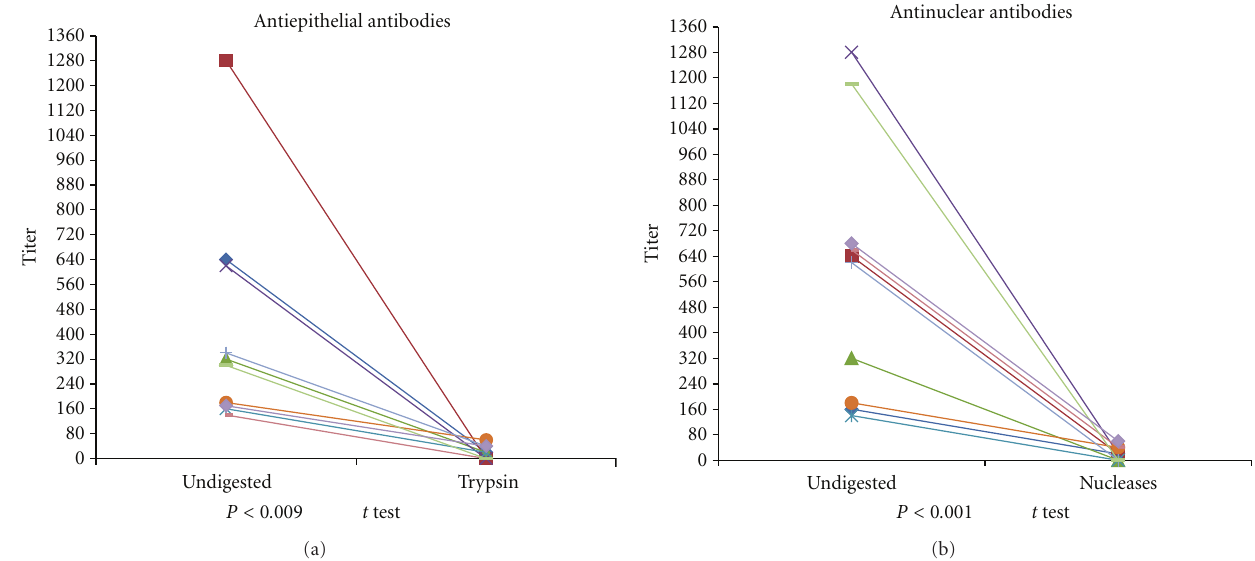
Figure 2: Antigenic digestion of cow nose using enzymes. (a), trypsin digestion abrogated the antiepithelial antibody (AEA) titers. (b), nuclease (RNAse/DNAse) digestion abrogated the antinuclear antibody (ANA) titer, as demonstrated by indirect immunofluorescence.